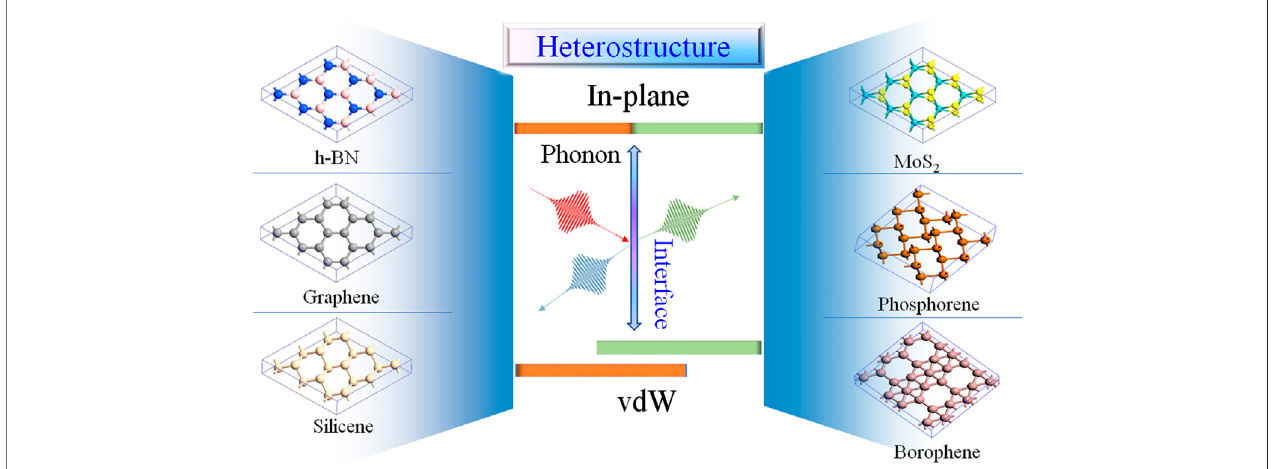
FIGURE 1 | Representative 2D materials and the schematic view of 2D heterostructures based on them.